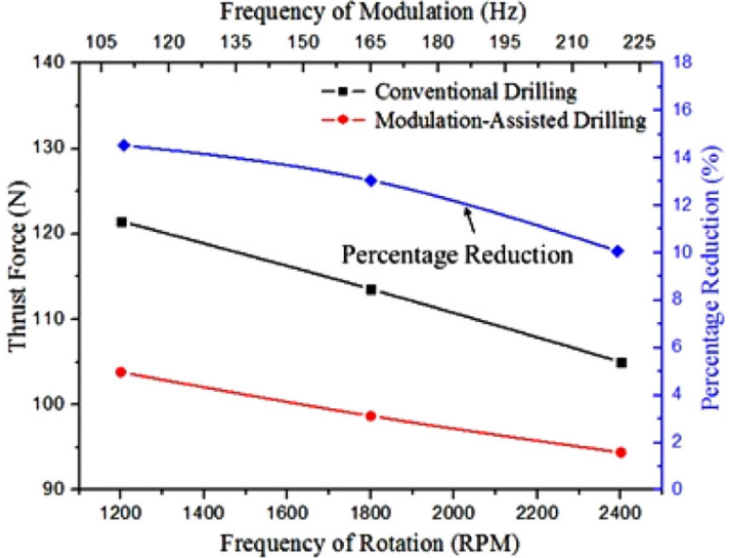
Figure 13. Effect of frequency of rotation on thrust force during drilling with 4-facet drill (Reprinted with permission from Ref. [146], 2016, copyright The Society of Manufacturing Engineers. Published by Elsevier Ltd.).